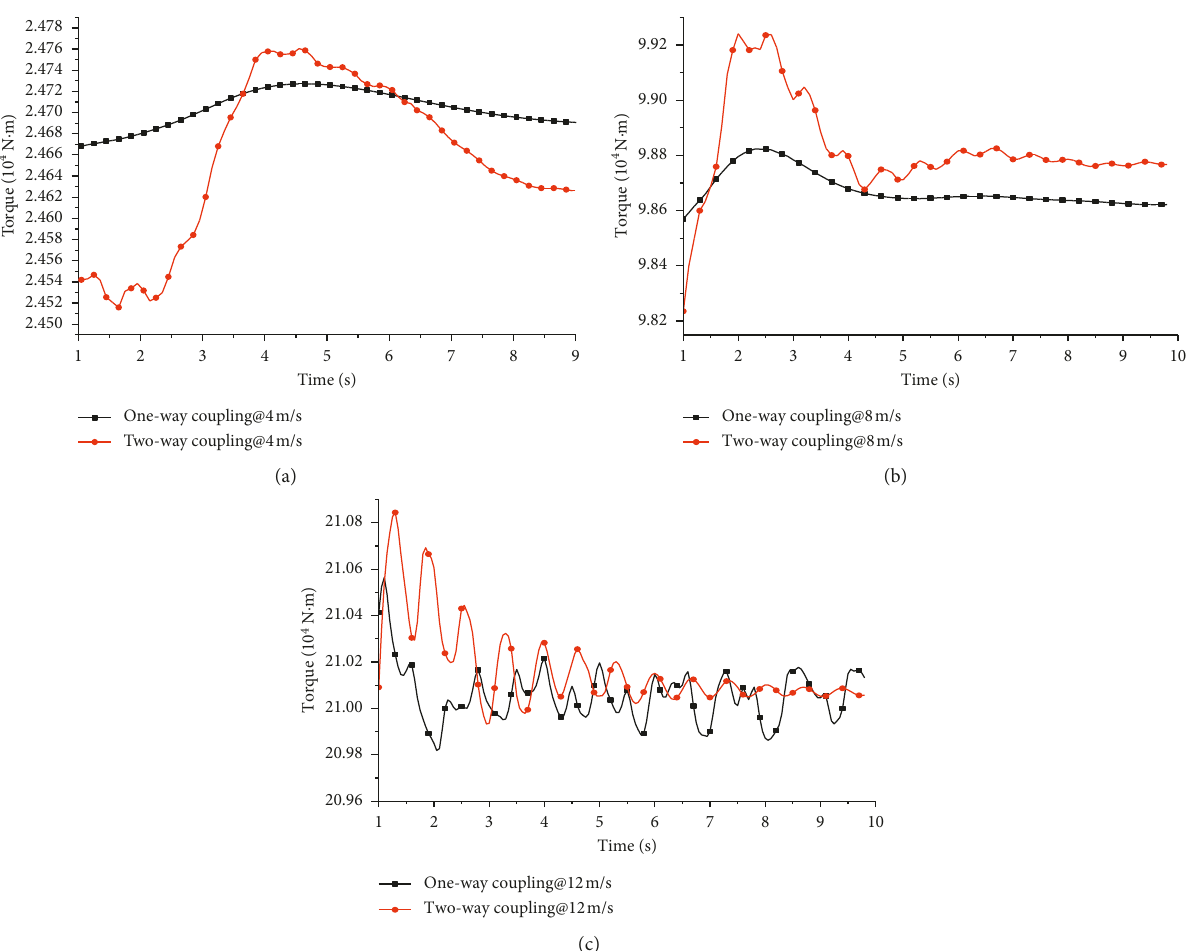
Figure 6: Torque varies with time at different wind speeds: (a) v � 4m/s; (b) v � 8 m/s; (c) v � 12m/s.